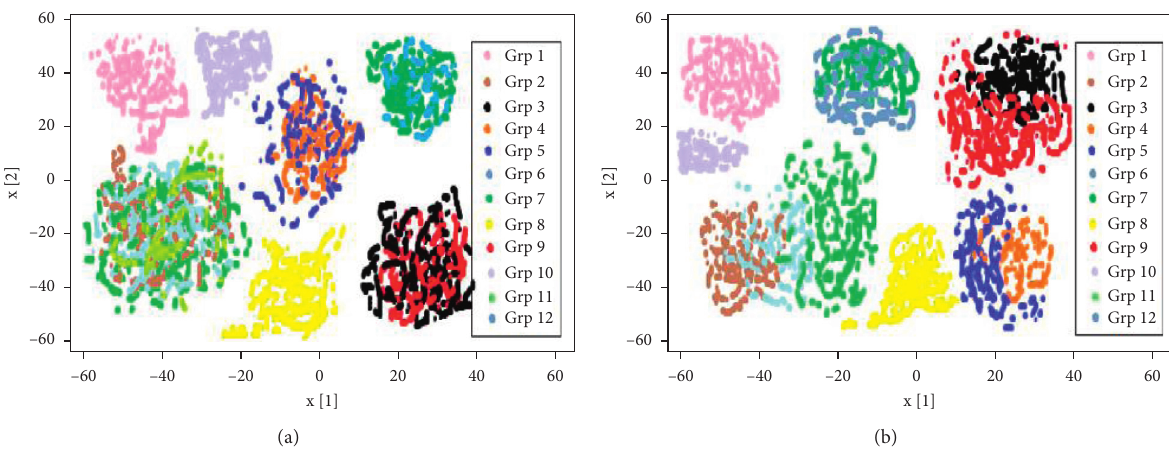
Figure 9: Visualization of (a) pixel-based and (b) structure-based data of our dataset of handwritten Urdu characters using standard t -SNE took 12 minutes 31 seconds. (a) Perplexity: 30 Iterations: 1,000. (b) Perplexity: 50 Iterations: